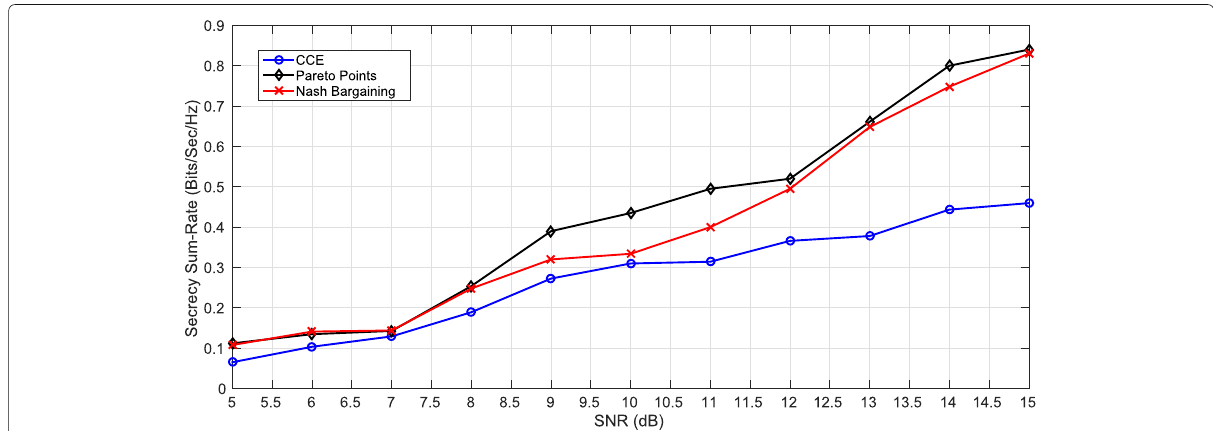
Fig. 10 FMAC-WT: sum rate comparison of CCE, PP and NBS for multiple rate case (with CSI of Eve)